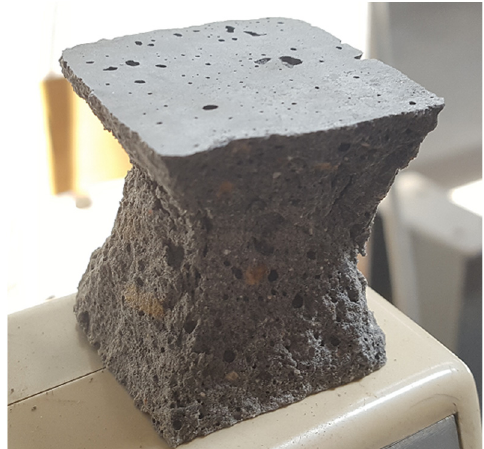
Figure 6. Fly ash-based AAB mortar specimen displaying conical semi-explosive failure.